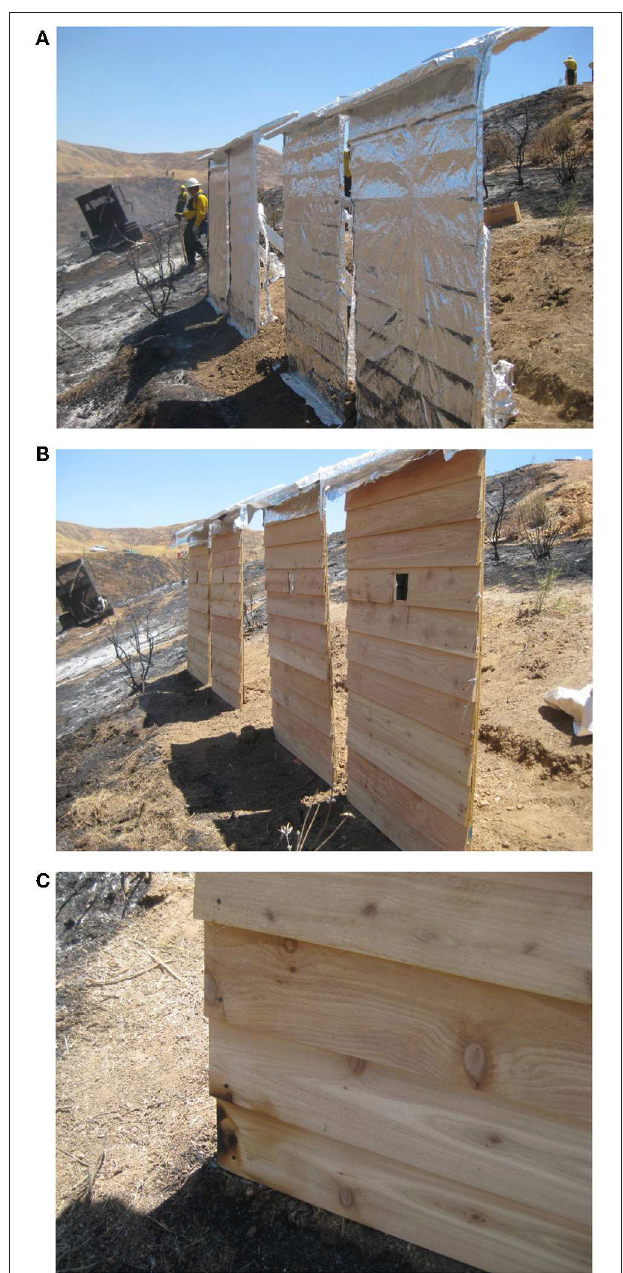
FIGURE 7 | Photographs of the structures after Burn #2. (A) All four different fire blankets were undamaged and (B) the wood panels are also undamaged, except for (C) a coin-size scorching area on the bottom left corner of the leftmost Panel